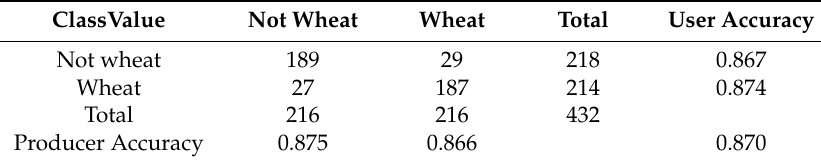
Table 6. Confusion matrix of 2017 wheat classification trained by 2016